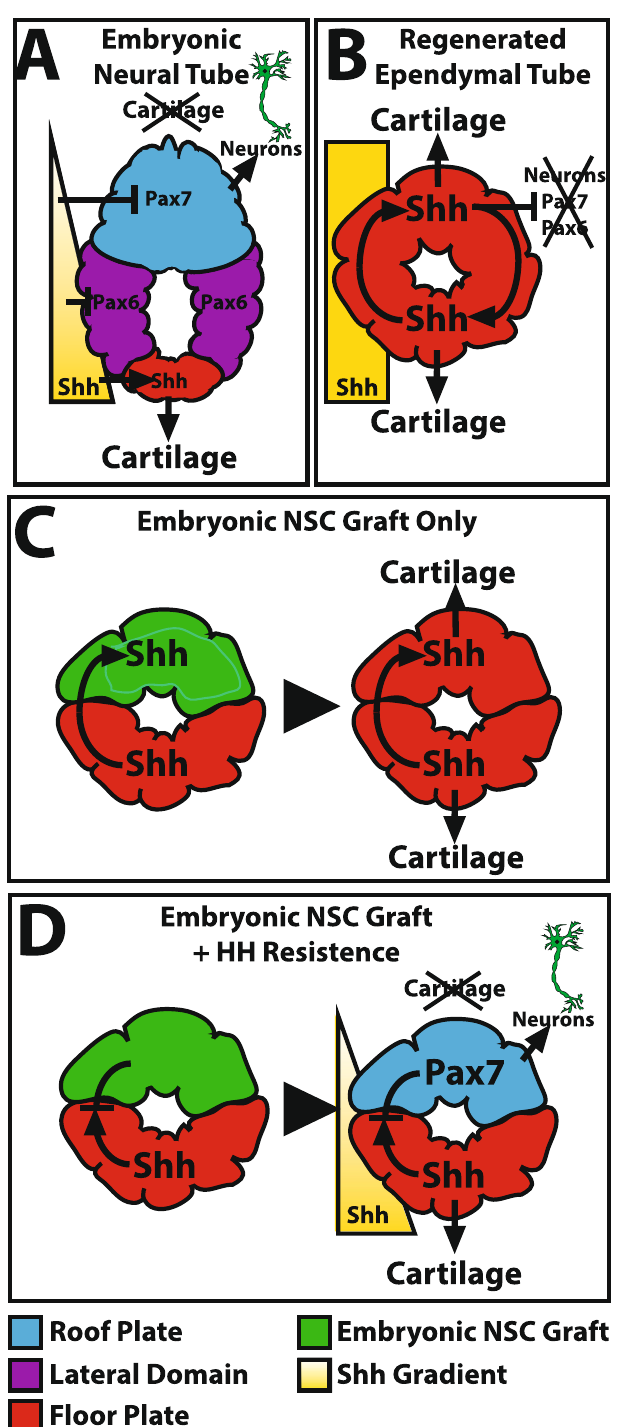
Fig. 7 Schematic representation of the dorsoventral patterning signals present during lizard tail development and regeneration. A Embryonic lizard tail neural tubes contain Pax7 + roof plate, Pax6 + lateral domains, and Shh + fl oor plates. Hedgehog signaling induces embryonic NSC ventralization and neurogenesis in addition to cartilage formation in surrounding cells. Shh expression restricted to fl oor plates results in Hedgehog signaling gradients that maintain dorsoventral patterning